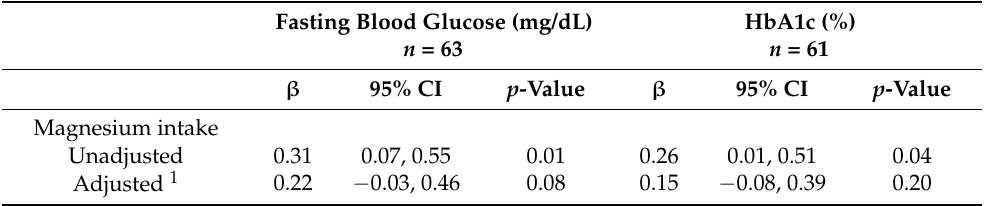
Table 2. Association between magnesium intake and glycemic markers.